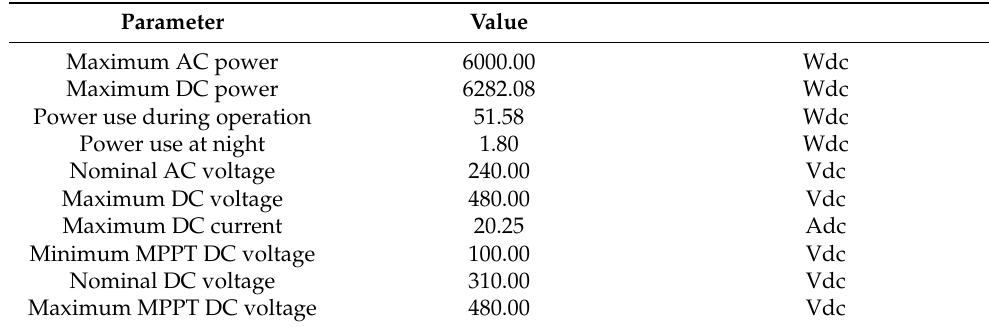
Table 3. Inverter characteristics. Courtesy of NREL [37].